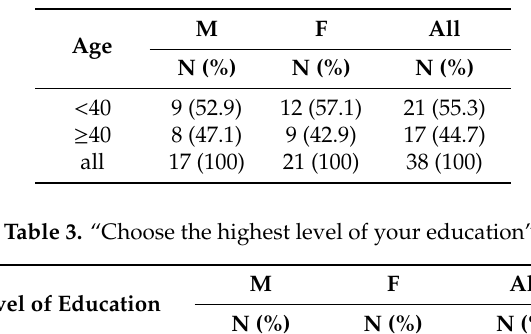
Table 2. “Respondents by sex and age group”.